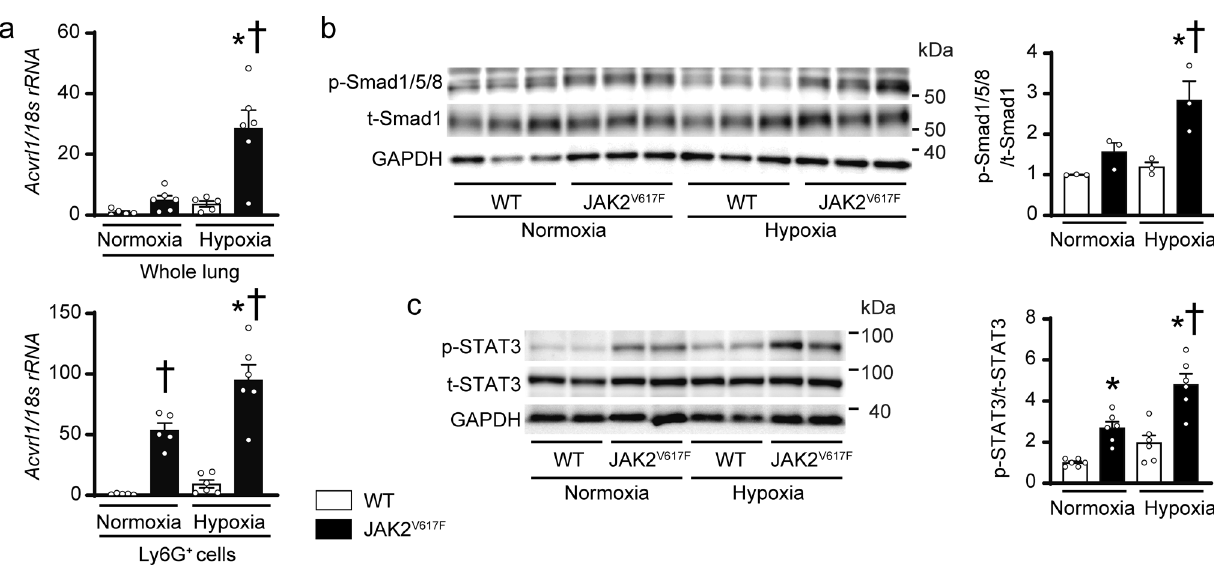
Fig. 6 Acvrl1 mRNA expressions and phosphorylation of Smad1/5/8 and STAT3 in the lungs of JAK2 V617F mice in response to chronic hypoxia. a mRNA expression of Acvrl1 in whole lung extracts (top) or the sorted Ly6G + cells from the lungs (bottom) of WT mice and JAK2 V617F mice exposed to normoxia or hypoxia. The data were normalized to 18 s rRNA levels ( n = 5, 6, 5, 6, * P = 0.0004, † P = 0.0004 for whole lung extracts, n = 5, 5, 6, 6, * P = 0.0069, † P = 0.0012 [left], <0.0001 [right] for sorted Ly6G + cells). Western blot analysis on the SMAD ( b ) and STAT ( c ) pathways in the lungs. Lung extracts from WT mice or JAK2 V617F mice were immunoblotted with the indicated antibodies. The ratios of phosphorylated Smad1/5/8 (p-Smad1/5/ 8) to total Smad1 (t-Smad1) and phosphorylated-STAT3 (p-STAT3) to total STAT3 (t-STAT3) are shown in the bar graphs. The average value for normoxia-WT mice was set to 1 ( b , n = 3 in each group, * P = 0.0382, † P = 0.0100; c , n = 6 in each group, * P = 0.0125 [left], 0.0019 [right], † P < 0.0001). GAPDH was used as the loading control. All data are presented as mean ± SEM. * P < 0.05 versus the corresponding normoxia-group and † P < 0.05 versus the corresponding WT mice by the one-way ANOVA with Tukey post-hoc analysis. Source data are provided as a Source Data fi